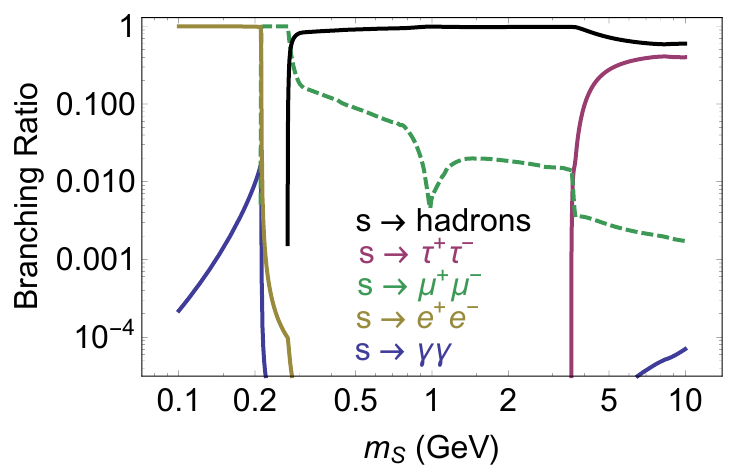
Figure 9 . Scalar branching ratios in the light hadron region used in this work. For masses below (cid:24) 1 : 4 GeV, we use ref. [104]. We use a smooth extrapolation in the region from 1 : 4 GeV to 2 m D